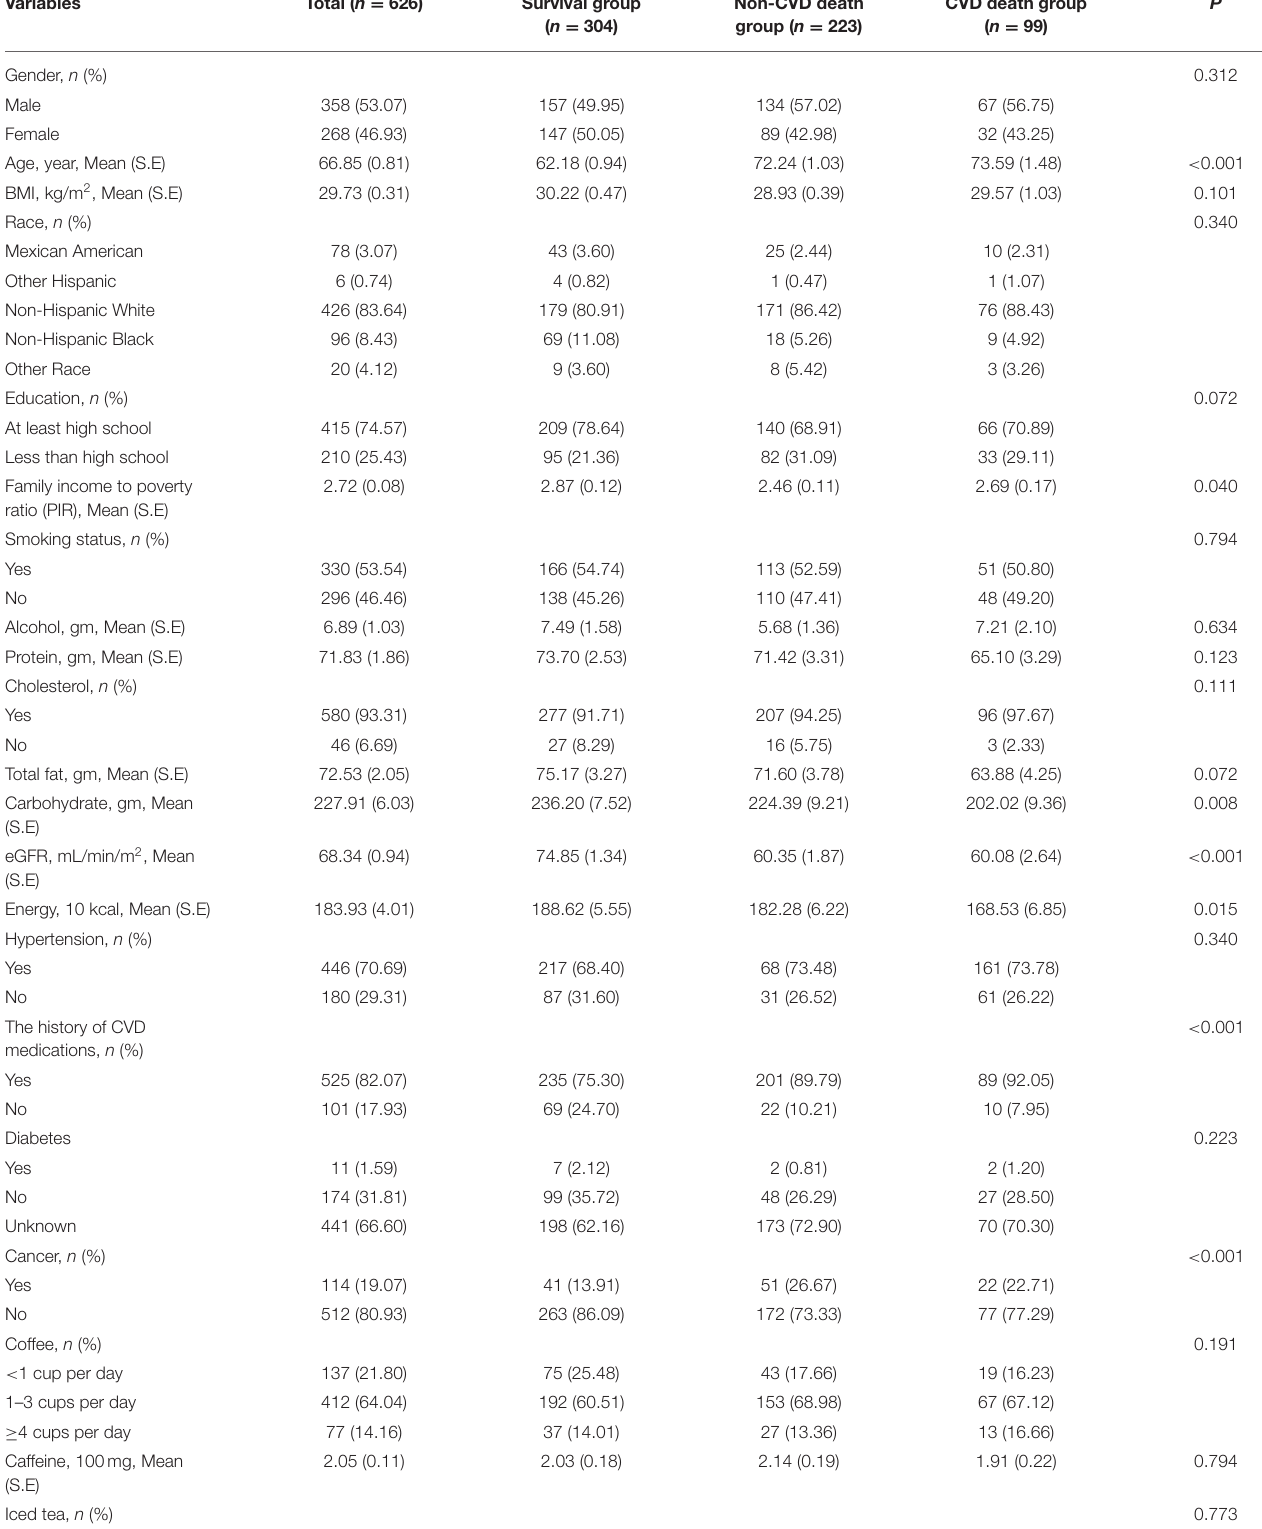
TABLE 1 | Baseline characteristics of all included